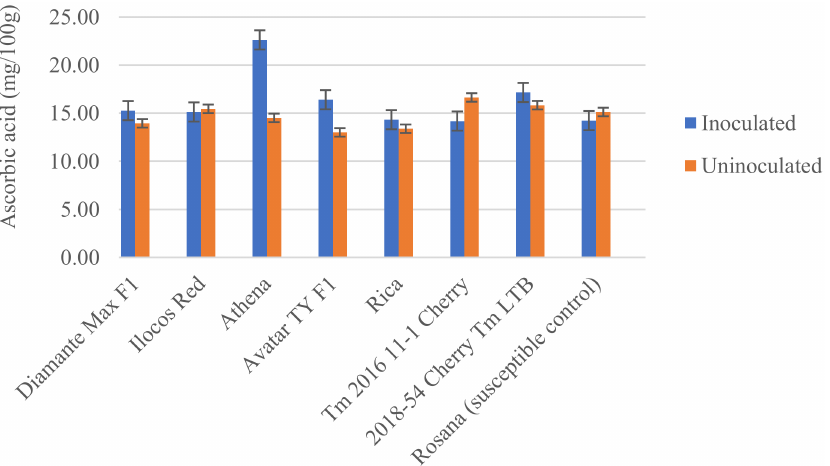
Figure 6. Average ascorbic acid of extracts from different tomato varieties tested against Meloidogyne incognita . Error bars represent standard error of the